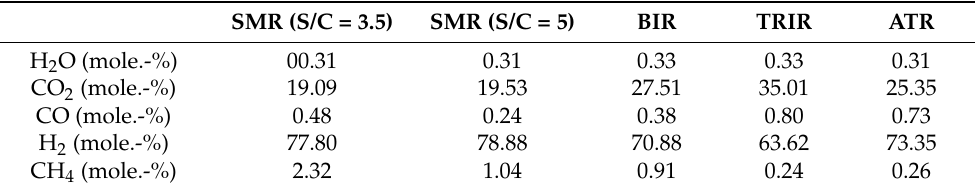
Table 6. Outlet flow